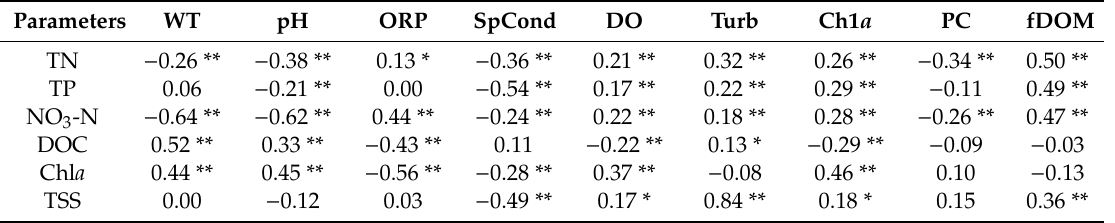
Table 2. Pearson correlation coe ffi cients between water quality parameters and high-frequency sensor